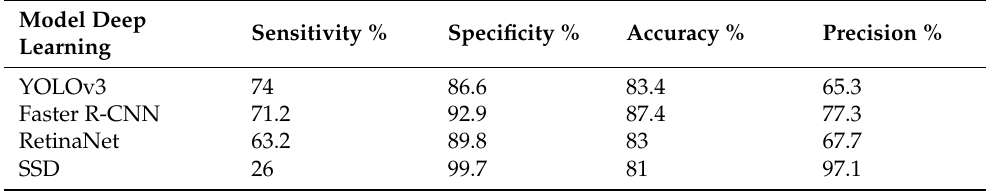
Table 1. Model evaluation: results of C vs. NC classification.